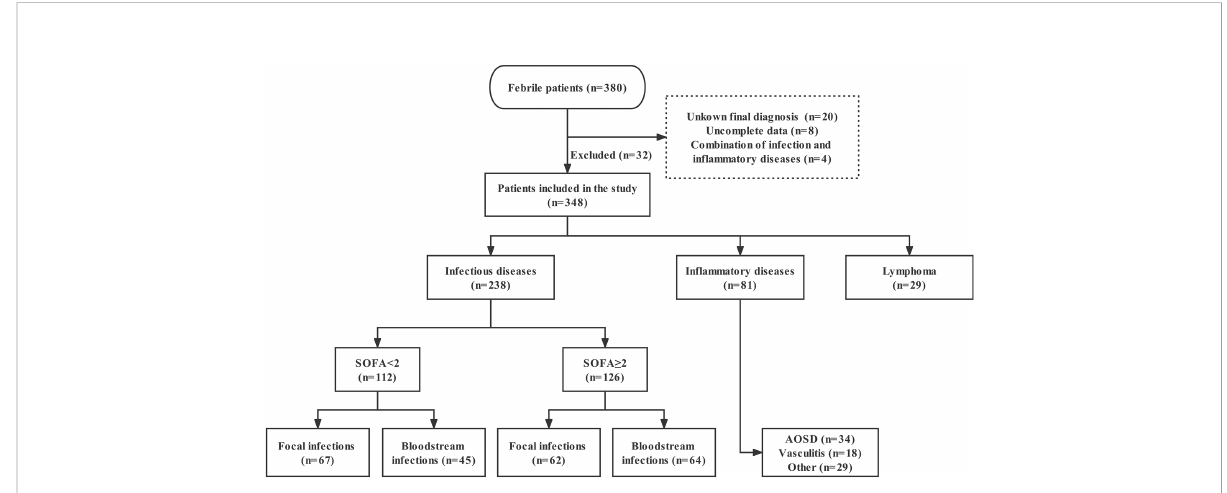
FIGURE 1 Study fl owchart of patients enrollment. SOFA, Sequential Organ Failure Assessment; AOSD, adult-onset Still ’ s